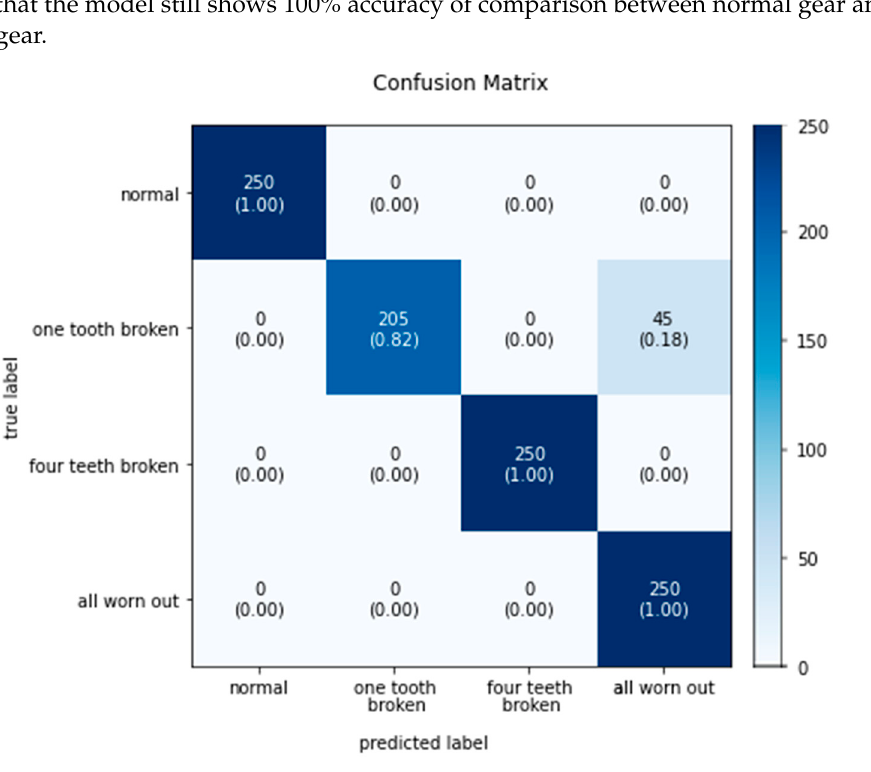
Figure 9. Confusion matrix of the test set calculated by the trained model.